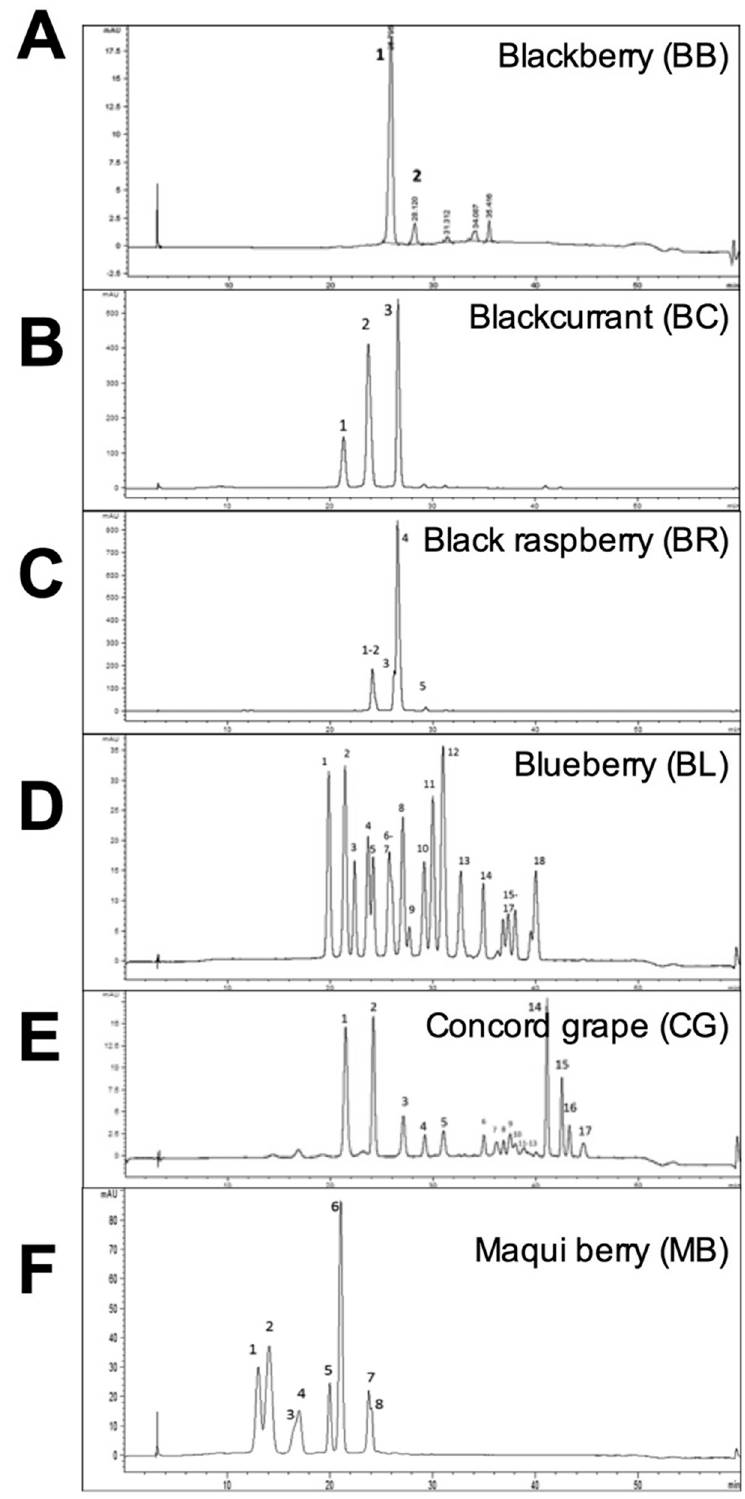
Figure 1. HPLC analysis of anthocyanins from whole freeze dried berries including ( A ) blackberry; ( B ) blackcurrant; ( C ) black raspberry; ( D ) blueberry; ( E ) Concord grape; and ( F ) maqui berry. Peak numbers correspond to Table 1 labels and order.